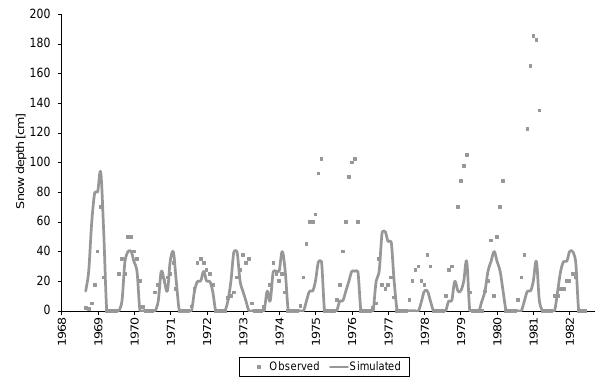
Fig. 2. Observed and simulated snow depth for the Ilulissat region. Observed snow depths are from Olesen (2003).